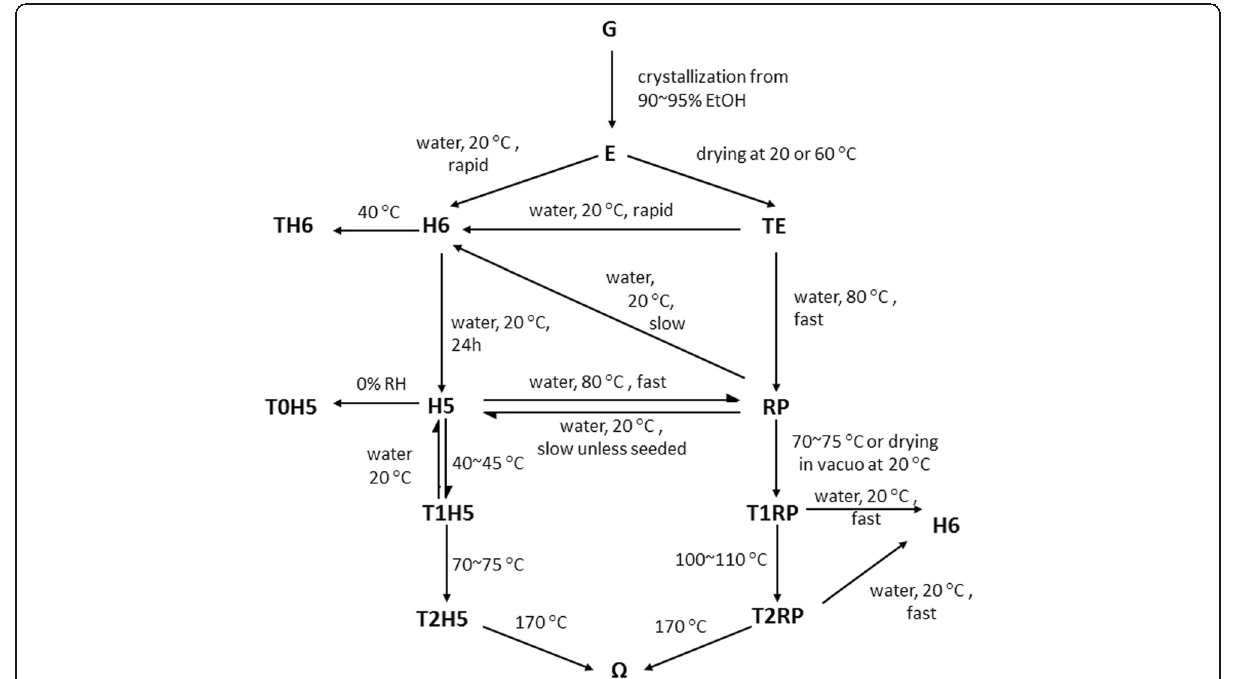
Fig. 11 Gatifloxacin crystalline forms from ethanaol, water, and various drying conditions (adapted from reference (Raghaven et al. 2002))